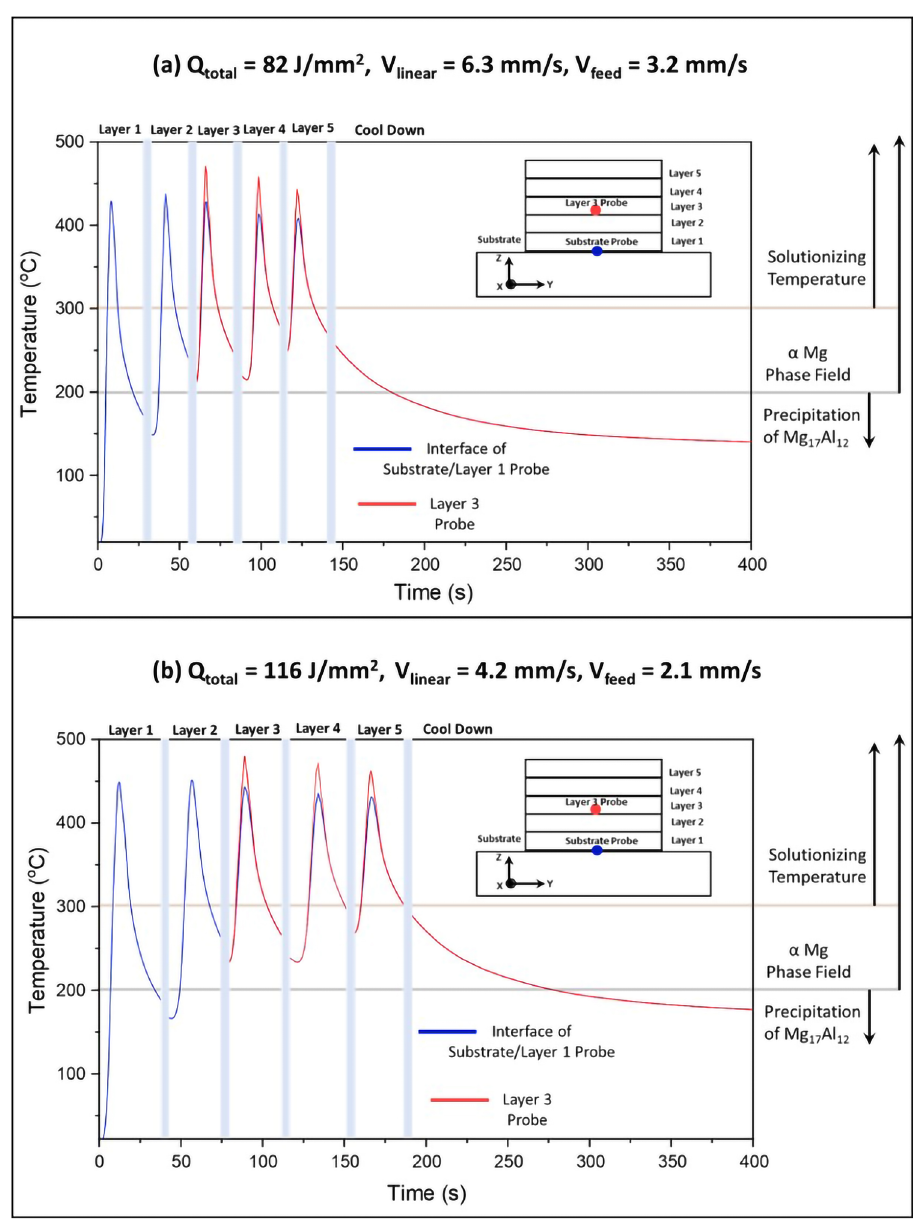
Figure 5. Predicted time-temperature plots for AFSD process using a multi layer computational process model 2 2 corresponding to ( a ) 82 J/mm and ( b ) 116 J/mm samples. Important phase transition and conventional heat treatment temperature ranges are indicated for